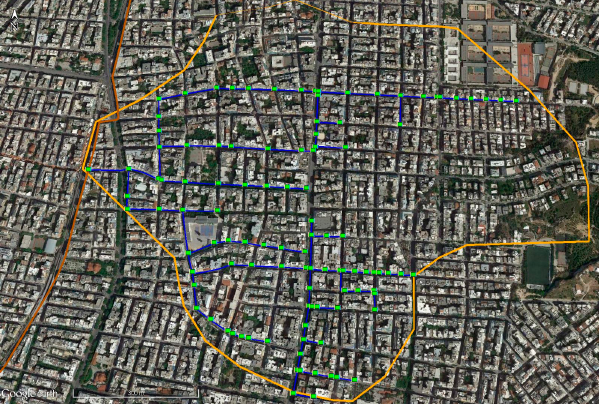
Figure 1. Aerial view of the study area (Google